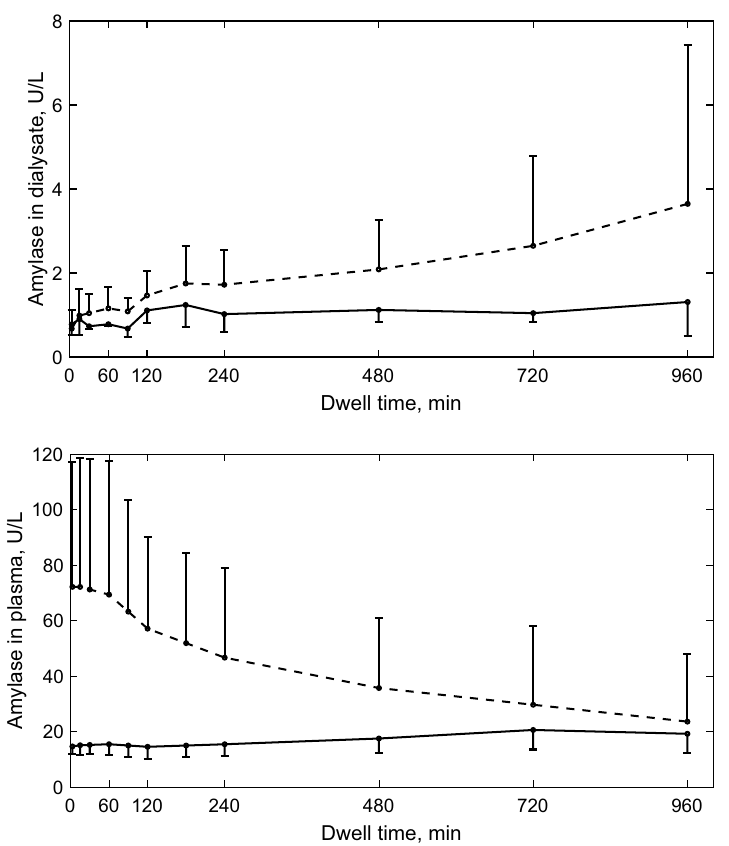
Figure 2. Mean ± SD values of α-amylase concentration (total activity) in dialysate (upper panel) and plasma (bottom panel) in Ico+ (solid line) and Ico− (dashed line) groups as a function of dwell